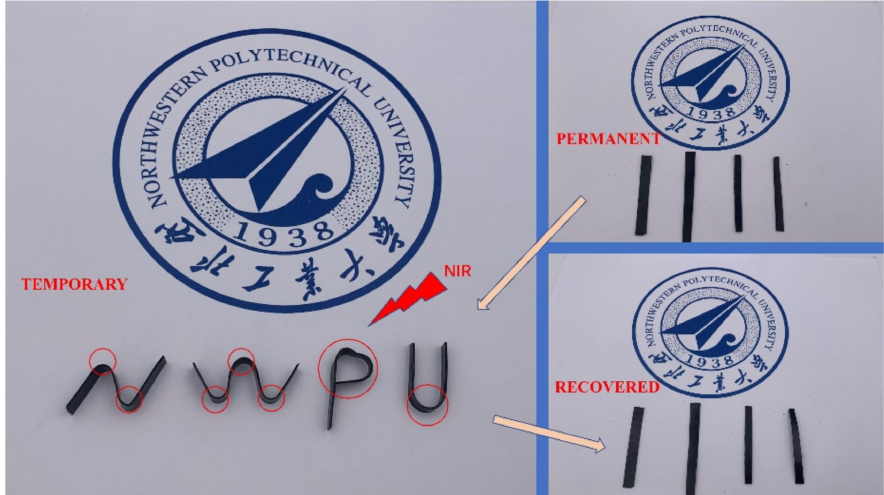
Figure 13. The shape memory process of EP-M@PDA-1.0% triggered by NIR.